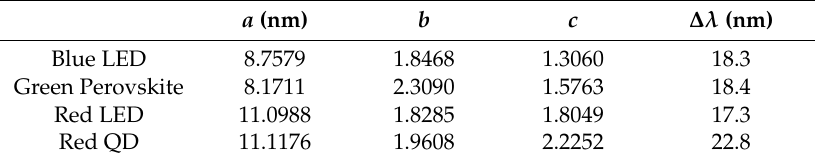
Figure 2. Spectral power distribution (SPDs) of blue LED, green perovskite-polymer downconverter, and red LED. The solid lines denote Gaussian fitting model and the dashed lines are based on precise fitting (SP7) model. Table 1. Fitting parameters in SP7 model of all variable SPDs.